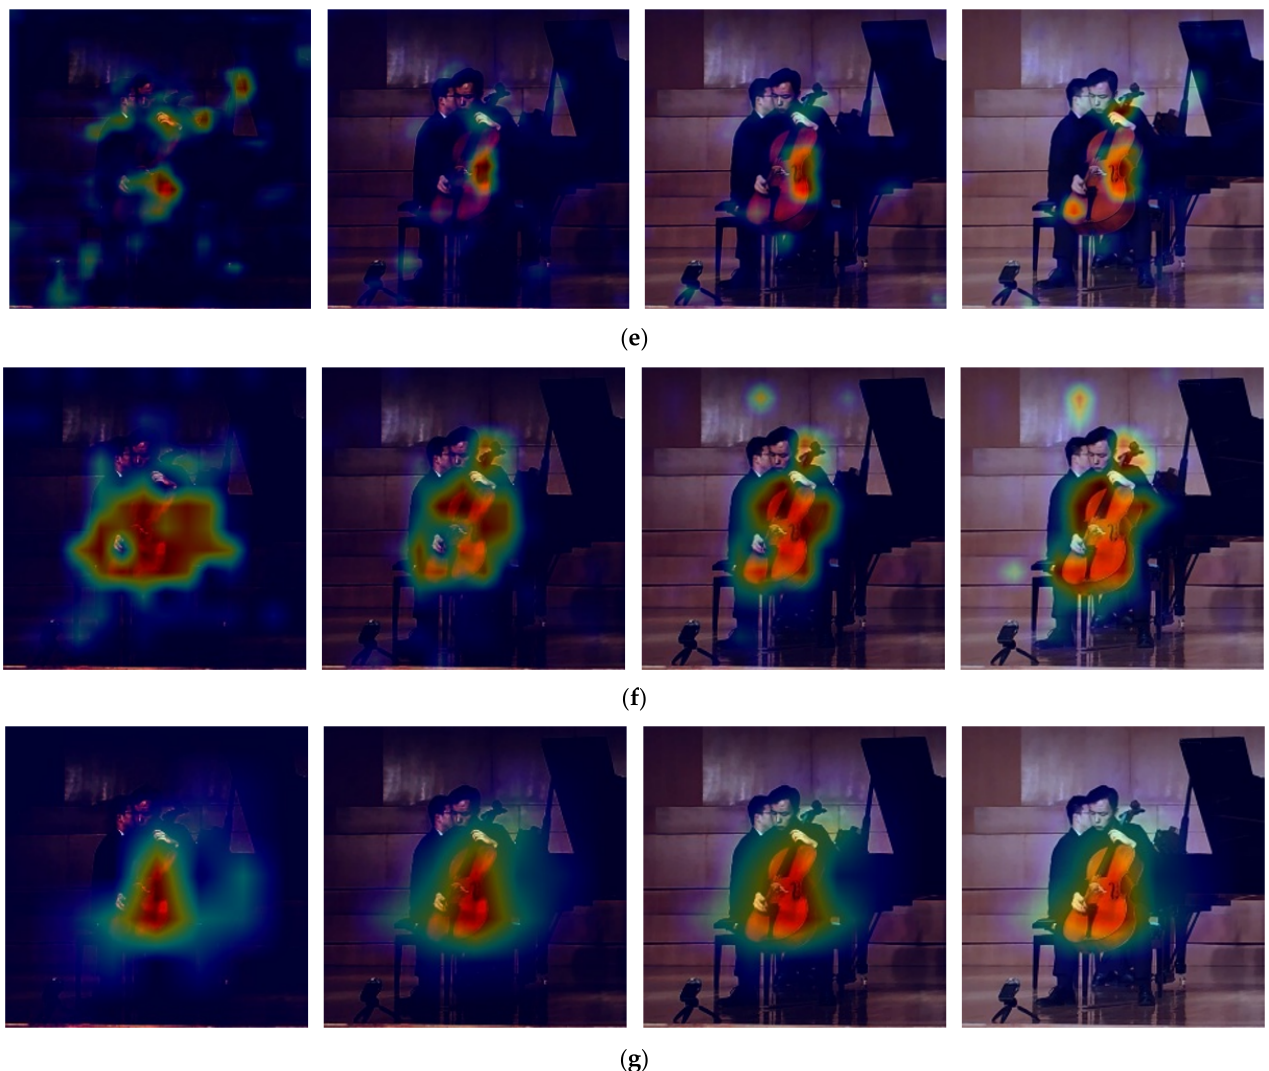
Figure 4. Feature map of different mainstream feature extraction network of cello. ( a ) Original image of different brightness levels; ( b ) MobileNet feature map; ( c ) ResNet-50 feature map; ( d ) ResNet-101 feature map; ( e ) VGG feature map; ( f ) Vision Transformer feature map; ( g ) swin-transformer feature map.